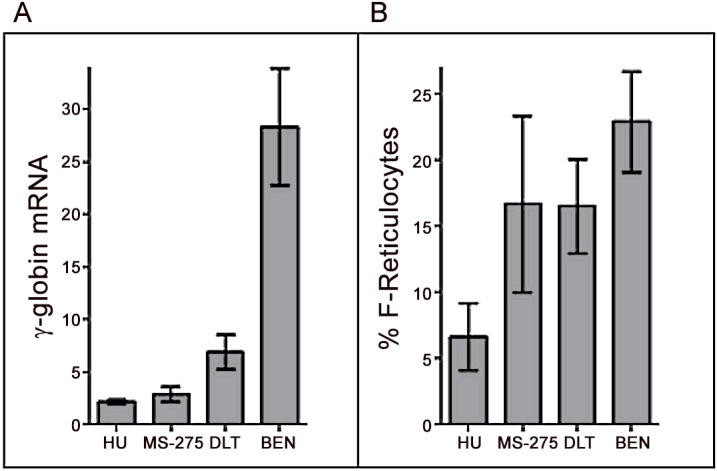
Comparison of fetal globin induction in anemic baboons treated with lead and known candidates.(A.) The magnitude of γ-globin mRNA induction with treatment with Hydroxyurea (HU), MS-275, DLT (mean 7-fold), and Benserazide (27-fold) are shown, and (B.) % F-reticulocytes with the drug treatments are shown. Error bars indicate standard deviation (SD).